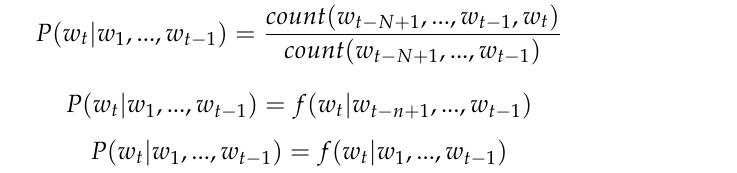
Most RNNs used for language modelling take the form of either LSTMs (Long Short Term Memory Networks) or GRUs because traditional vanilla RNNS are susceptible to the problem of vanishing or exploding gradients for very long sequences. LSTMs and GRUs have memory cells to alleviate this problem. A GRU [15] consists of memory cells with weights W and a function H applied to the input according to Equation (5). Each cell at a timestep t will have an input gate x , update gate u and reset gate r . All parameters are updated according to Equations (11)–(14).